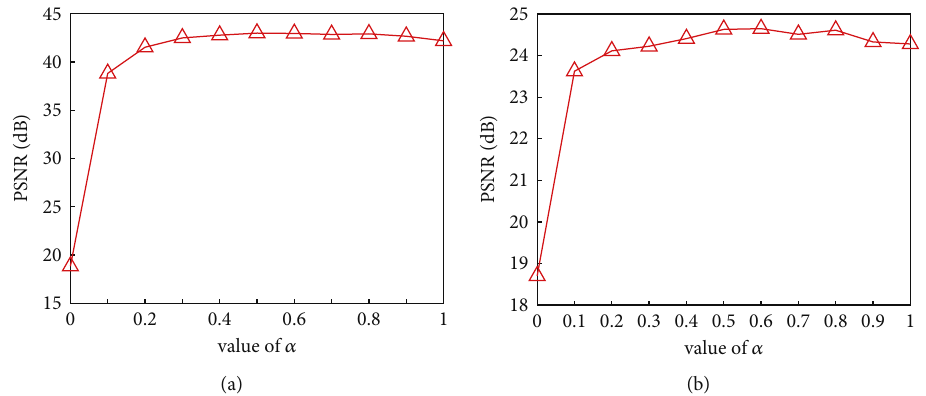
Figure 6: The PSNR values with di ff erent alpha and 30-view simulated data. (a) The line chart displays the quantitative results of noiseless data, and (b) the line chart shows the quantitative results of noisy observation with SNR = 10 dB.